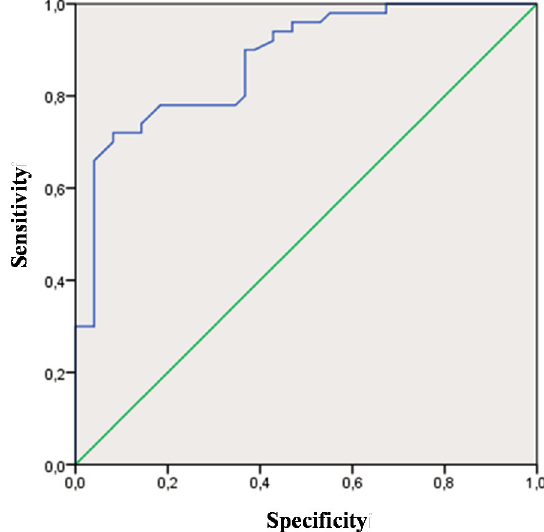
Figure 1. Receiver-operating characteristic curve (ROC) for the TGF- β variable (AUC 0.878; p = 0.0001; 95% CI (0.811–0.944)) revealing its diagnostic potential for